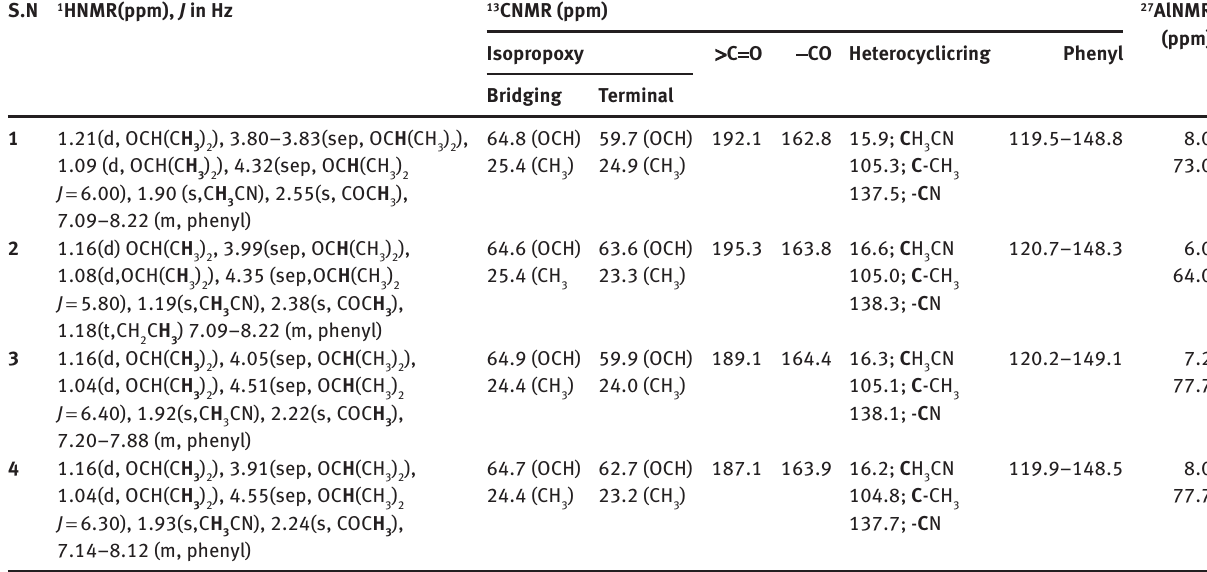
Table 1: 1 H, 13 C, and 27 Al NMR spectroscopic data of compounds [RC(O)C:C(O)N(Ph)N:CCH S.N 1 HNMR(ppm), J in Hz